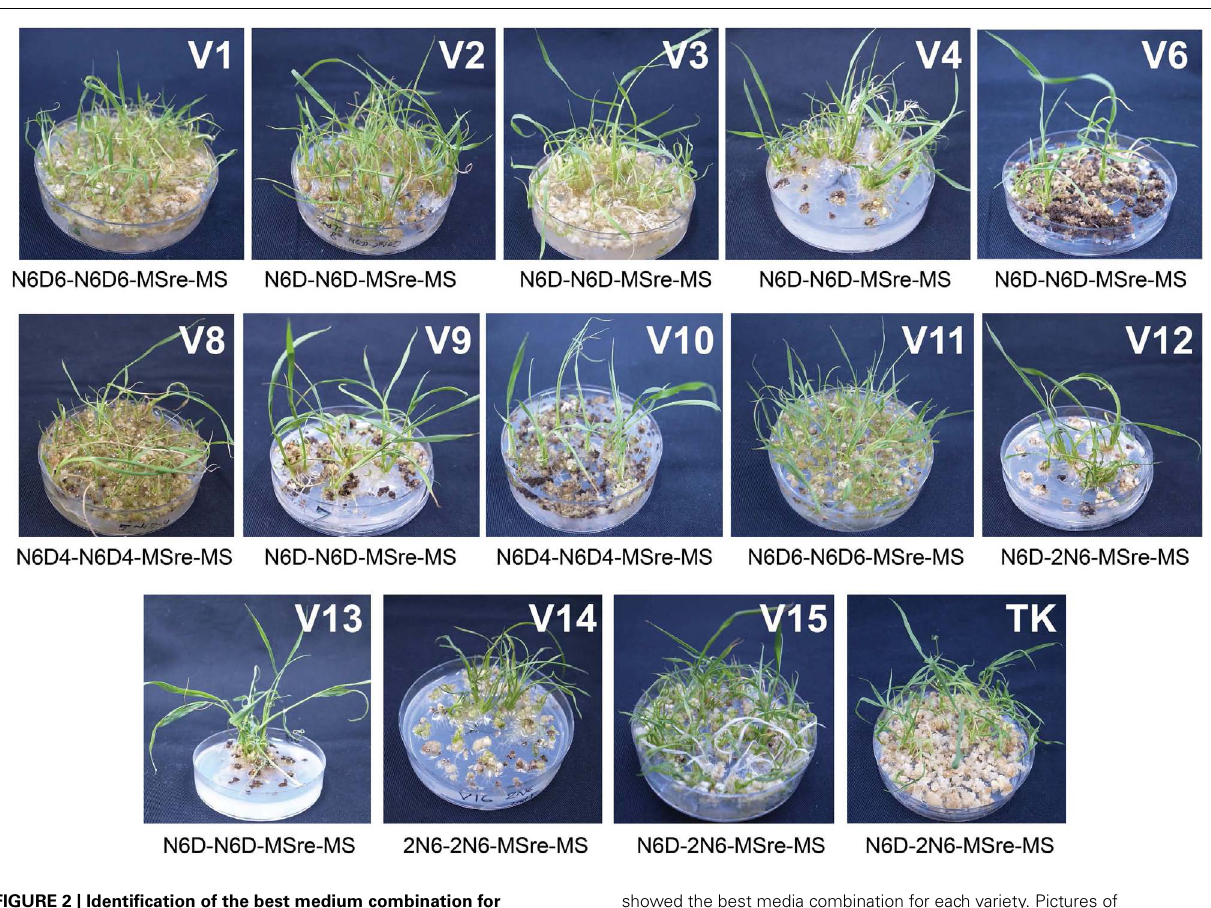
showed the best media combination for each variety. Pictures of regenerated plants were taken at 3days after acclimation. Pictures of V5 andV7 were not shown as regenerated plants were not obtained from these two